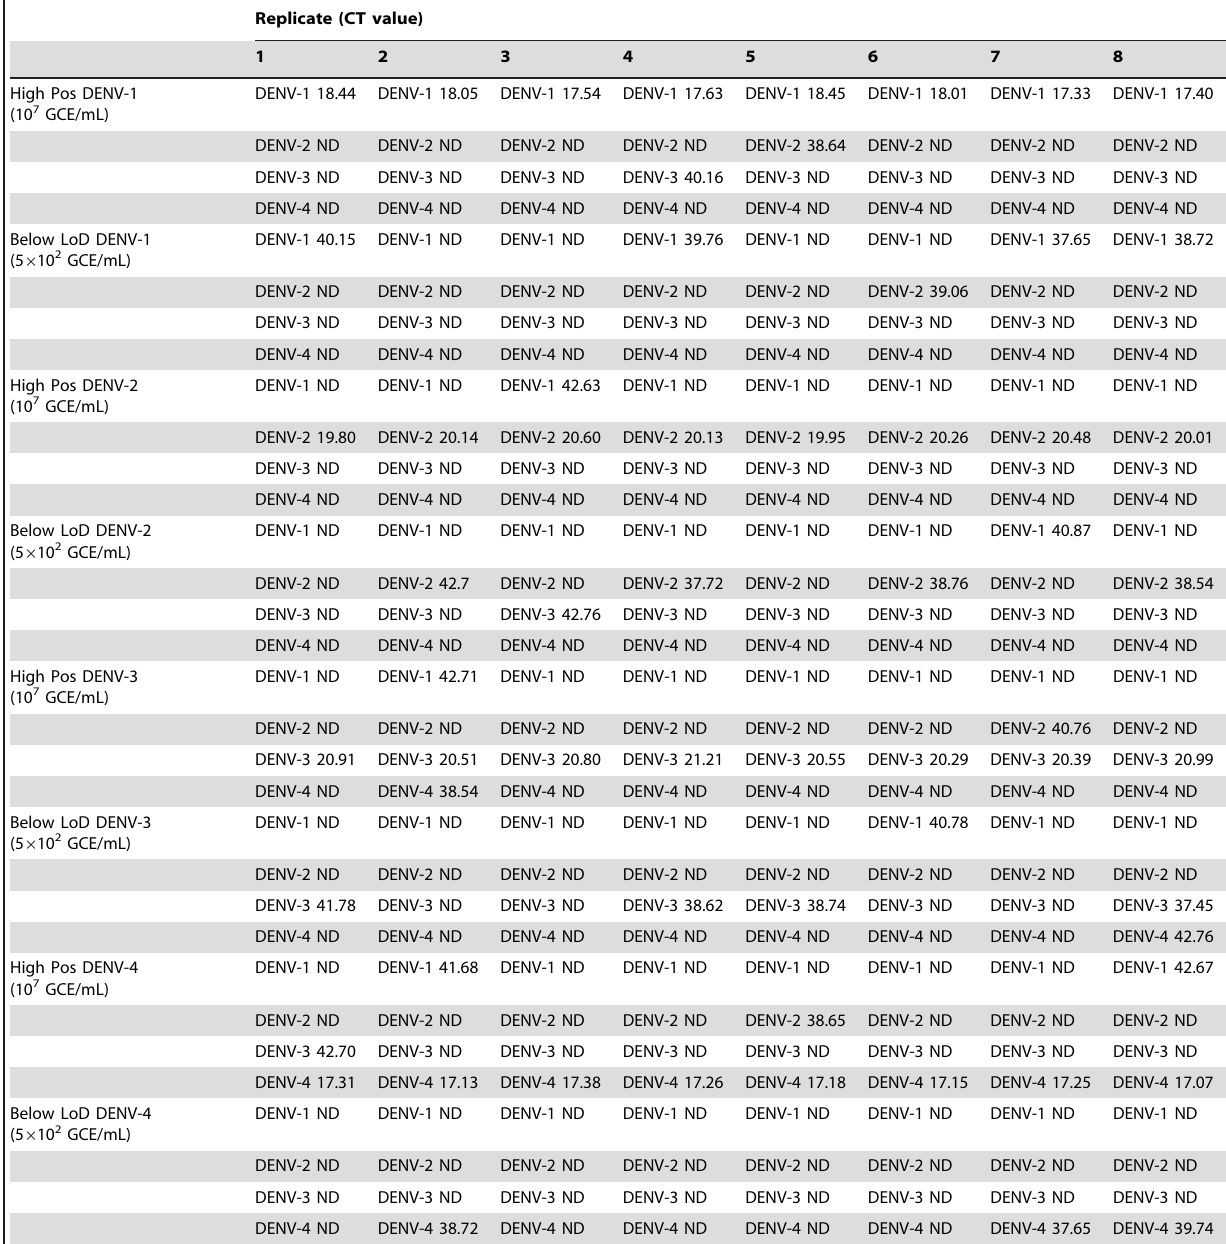
Table 5. Assessment of the potential for carryover